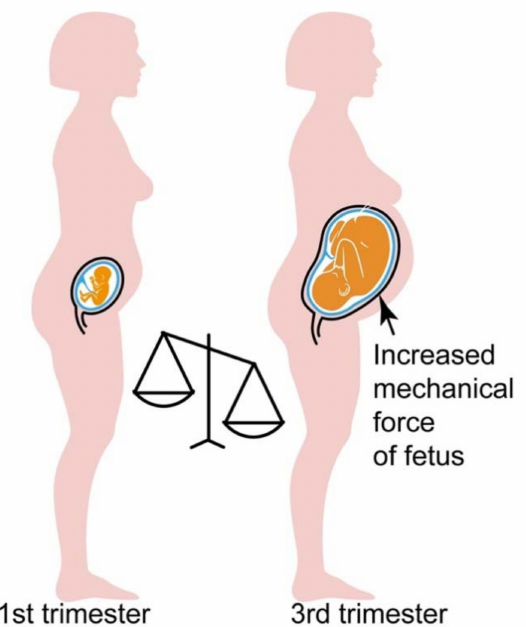
Figure 3. Mechanical forces are high in late-stage pregnancy. Due to the increasing fetal weight, mechanical forces are continuously rising in pregnancy. Consequently, mechanical forces are low in the 1st trimester ( left ), whereas in late-stage pregnancy (3rd trimester), the mechanical force induced by the increased fetal weight is high ( right